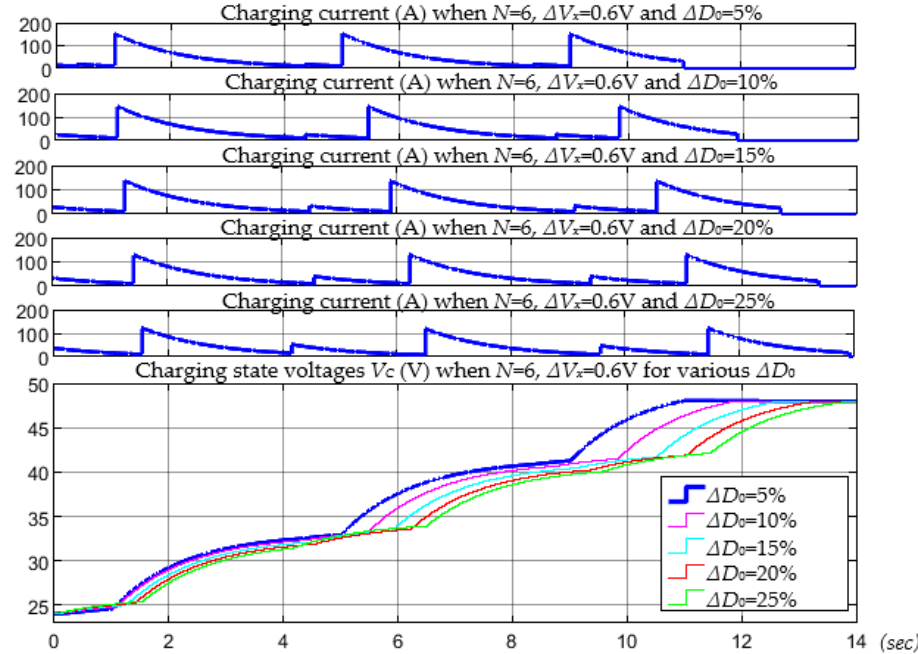
Figure 27. SC circuit charging currents and voltages in case of six-phase converter at different ∆ D 0 .